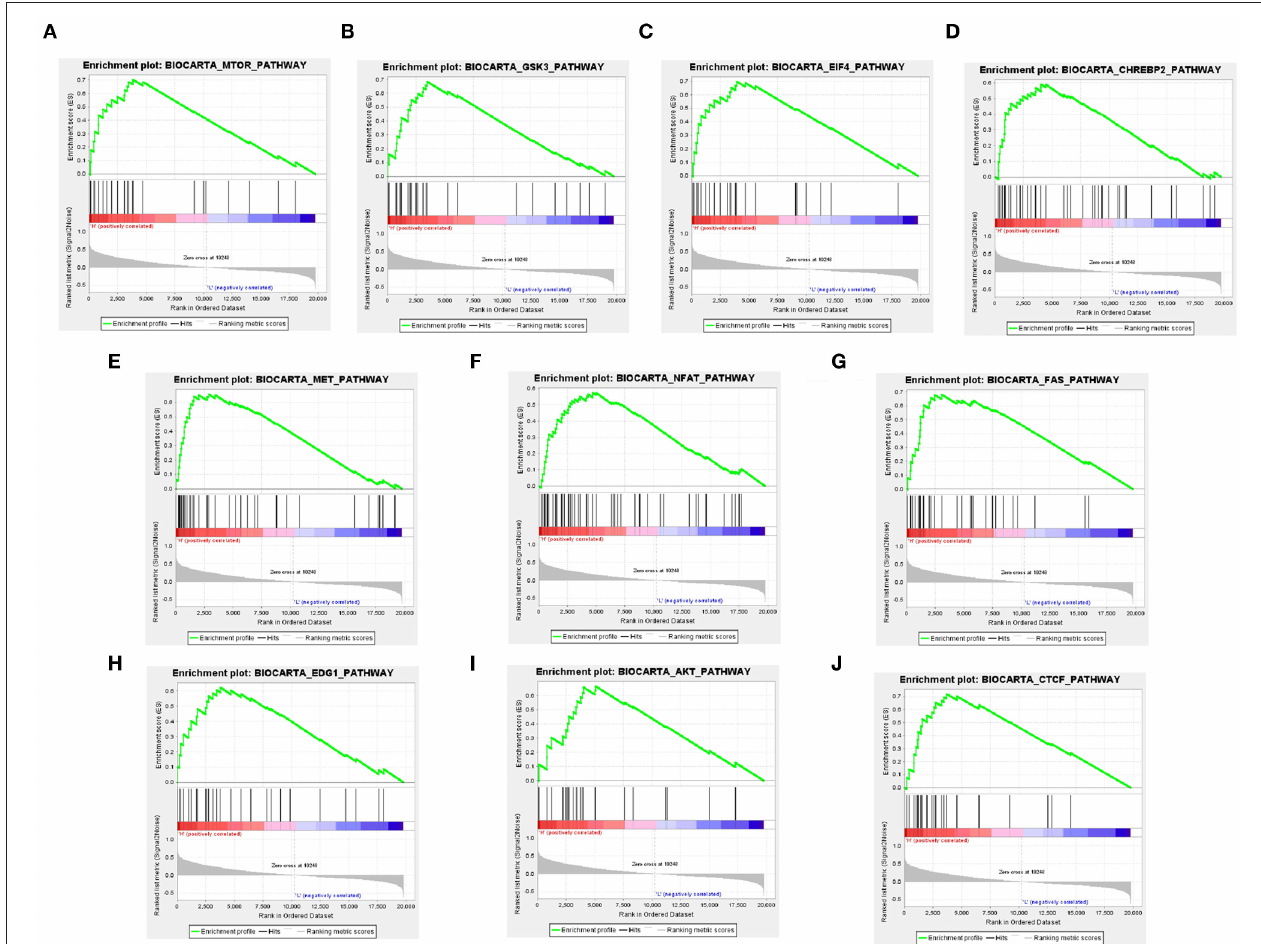
FIGURE 3 | Identification of YTHDF2-regulated multiple pathways in clear cell renal cell cancer (ccRCC) by Gene Set Enrichment Analysis (GSEA). GSEA results showing mTOR pathway (A) , GSK3 pathway (B) , EIF4 pathway (C) , CHREBP2 pathway (D) , MET pathway (E) , NFAT pathway (F) , FAS pathway (G) , EDG1 pathway (H) , AKT pathway (I) , and CTCF pathway (J) are differentially enriched in YTHDF2 increased expression phenotype. ES, enrichment score; NES, normalized ES; NOM, normalized P